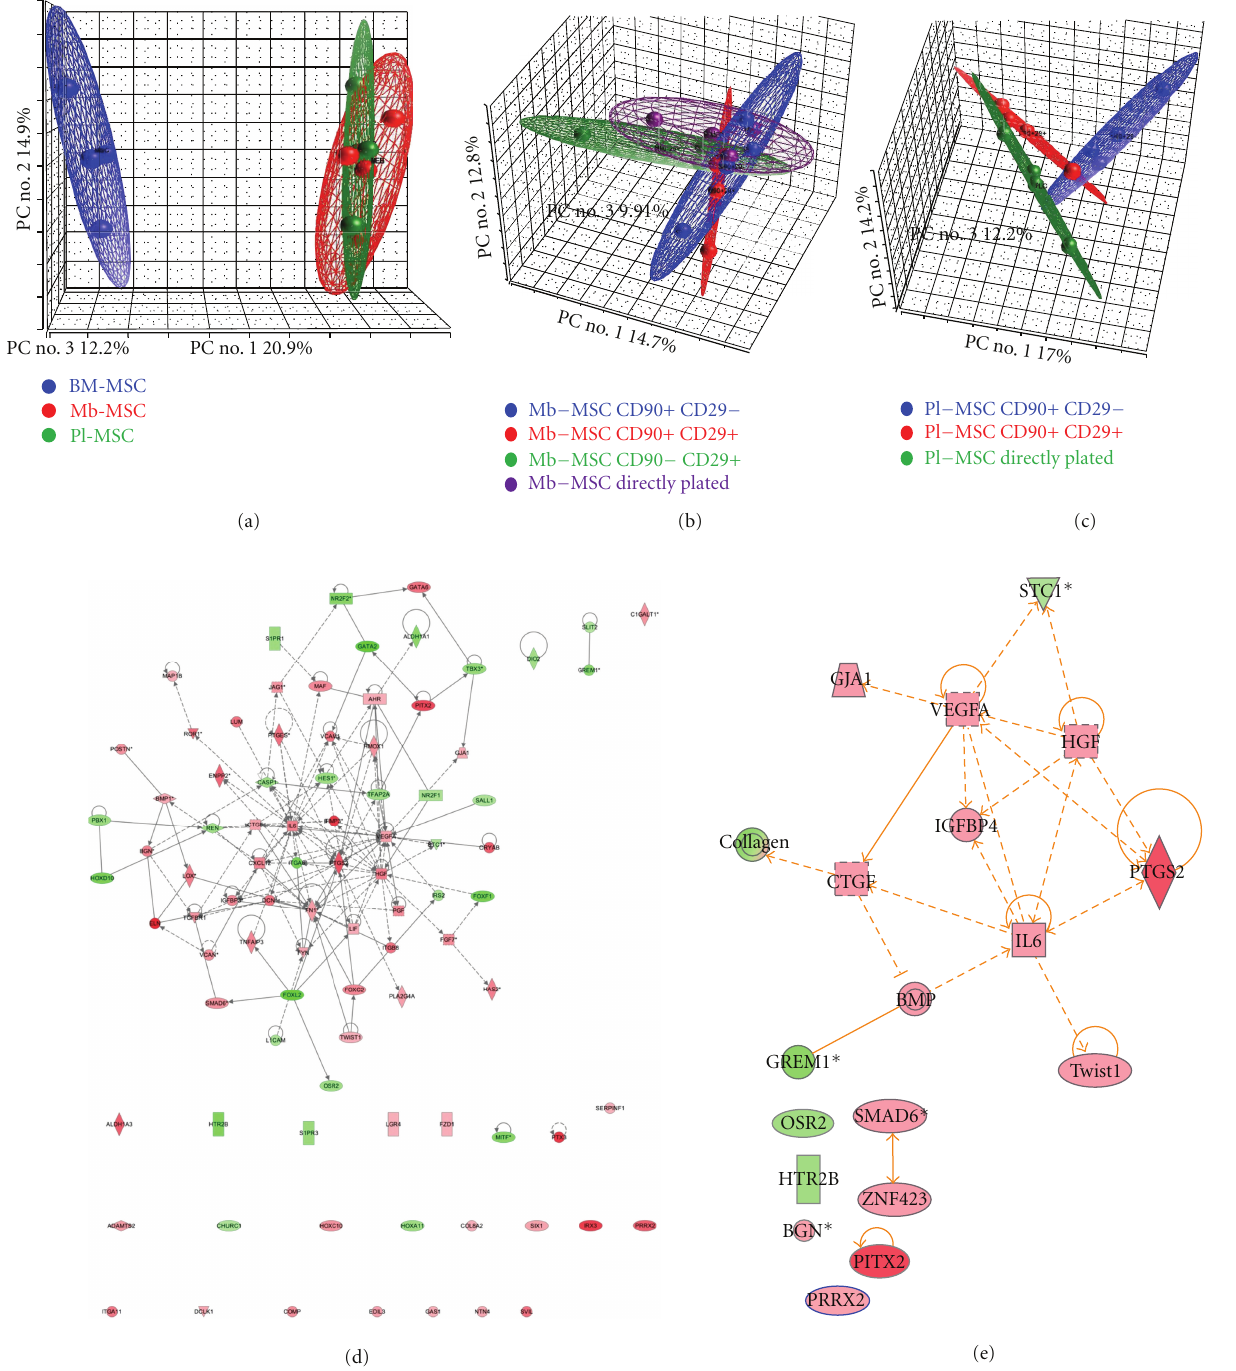
Figure 4: PCA representation of transcriptomic comparison of Pl-MSCs, Mb-MSCs and BM-MSCs and ingenuity pathways analysis. (a) Mb-MSCs (red) and Pl-MSCs (green) are overlapping clearly indicating the impossibility to di ff erentiate these MSCs at a transcriptional level. They can clearly be di ff erentiated from bone marrow MSCs (blue). (b) The PCA overlapping between every cell sorted sub-population from membrane (CD29 + CD90 + red; CD29 − CD90 + blue; CD90 − CD29 + green) or nonsorted cells (Mb-MSCs purple) indicate the impossibility to discriminate the di ff erent MSCs subpopulation at a transcriptional level. (c) PCA of di ff erent MSC subpopulation from placenta (CD29 + CD90 + red; CD29 − CD90 + blue) or directly isolated cells (Pl-MSCs blue) indicate the impossibility to discriminate these MSCs subpopulation at a transcriptional level. (d) Ingenuity pathway analysis was able to define enriched pathways implicated in